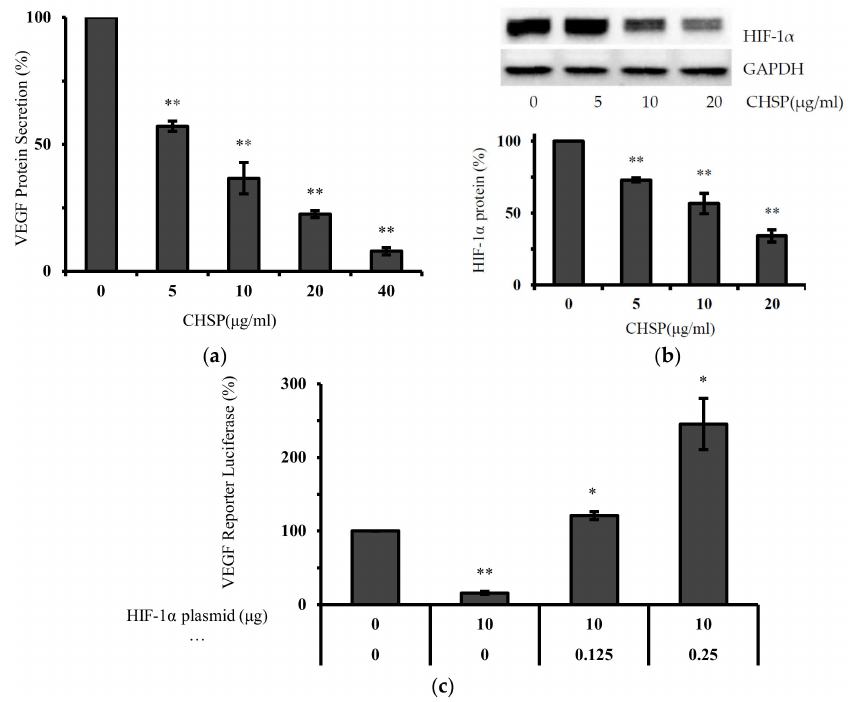
Figure 4. CHSP inhibited cell proliferation via the HIF-1 α / VEGF pathway in OVACAR-3 cells. ( a ) Cells were treated with CHSP for 24 h. Culture supernatants were collected for the VEGF assay by ELISA with a Quantikine Human VEGF Immunoassay kit. ( b ) CHSP decreased the levels of HIF-1 α and HIF-1 α bands were quantitated with NIH Image J software for analysis. ( c ) Cells were transfected with VEGF luciferase reporter and HIF-1 α plasmids. After transfection, all the cells were treated with or without CHSP (10 µ g / mL) for 16 h and the luciferase activity was determined. * p < 0.05 as compared to control. ** p < 0.01 as compared to control.